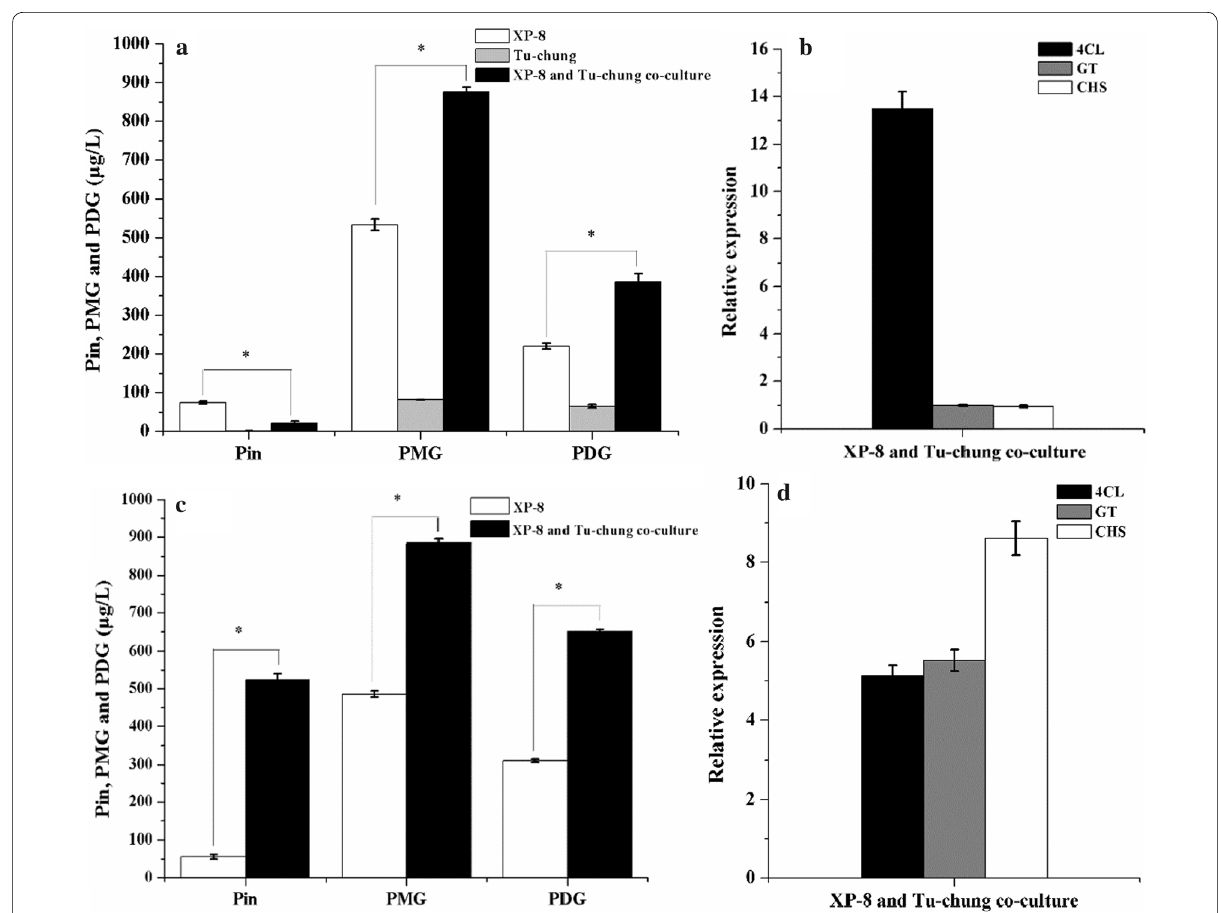
Fig. 4 Output levels of target products and expression levels of genes obtained using the method with PDB medium containing Tu-chung ( a , b ) and the resting cells ( c , d